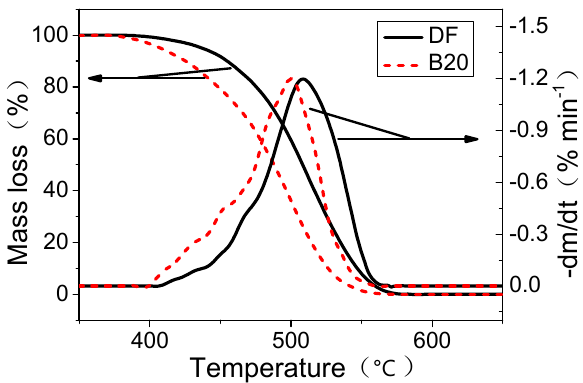
Figure 9. Typical TG and DTG profiles obtained from the soot sampled at BMEP = 0.782 MPa. Table 4. Peak temperature (T p ), burnout temperature (T b ) and apparent activation energy (E a ) for soot